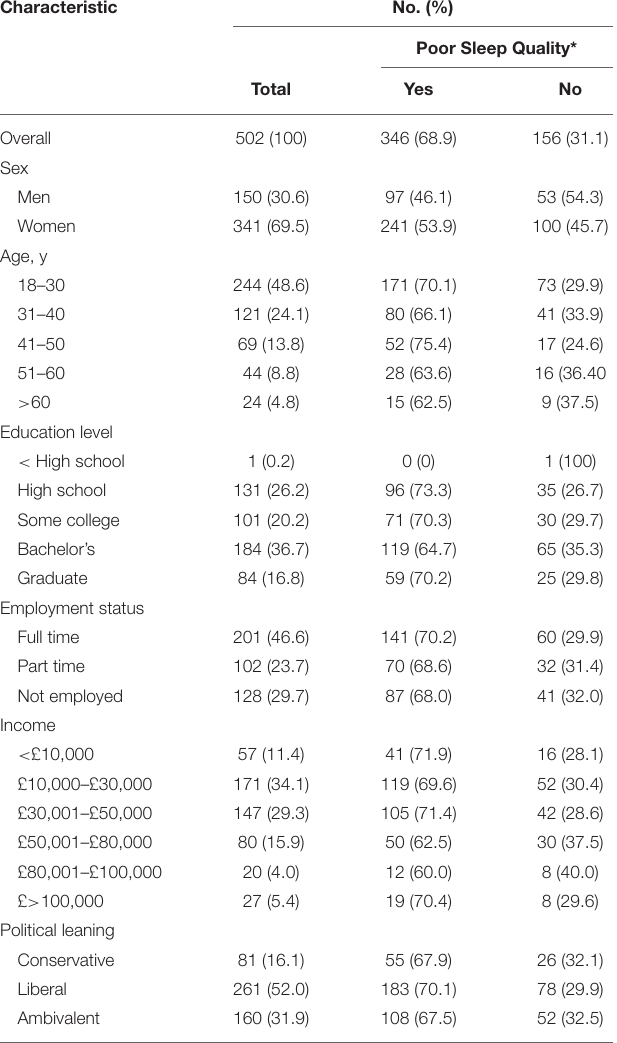
TABLE 3 | Sleep quality stratified by OPAS-C quartile. OPAS-C Quartile